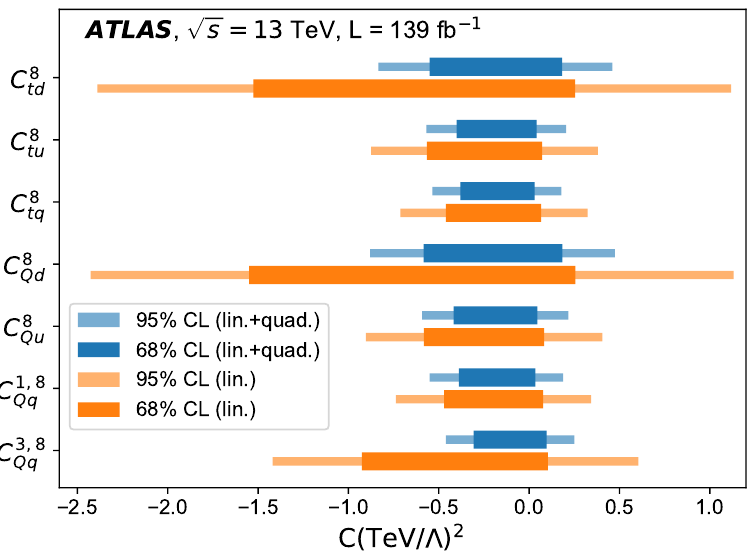
Figure 34 . A summary of one-dimensional limits on selected Wilson coefficients corresponding to 2-light-quark 2-heavy-quark operators. The limits are provided for cases where both linear and quadratic terms are included and for cases where only linear terms are included.